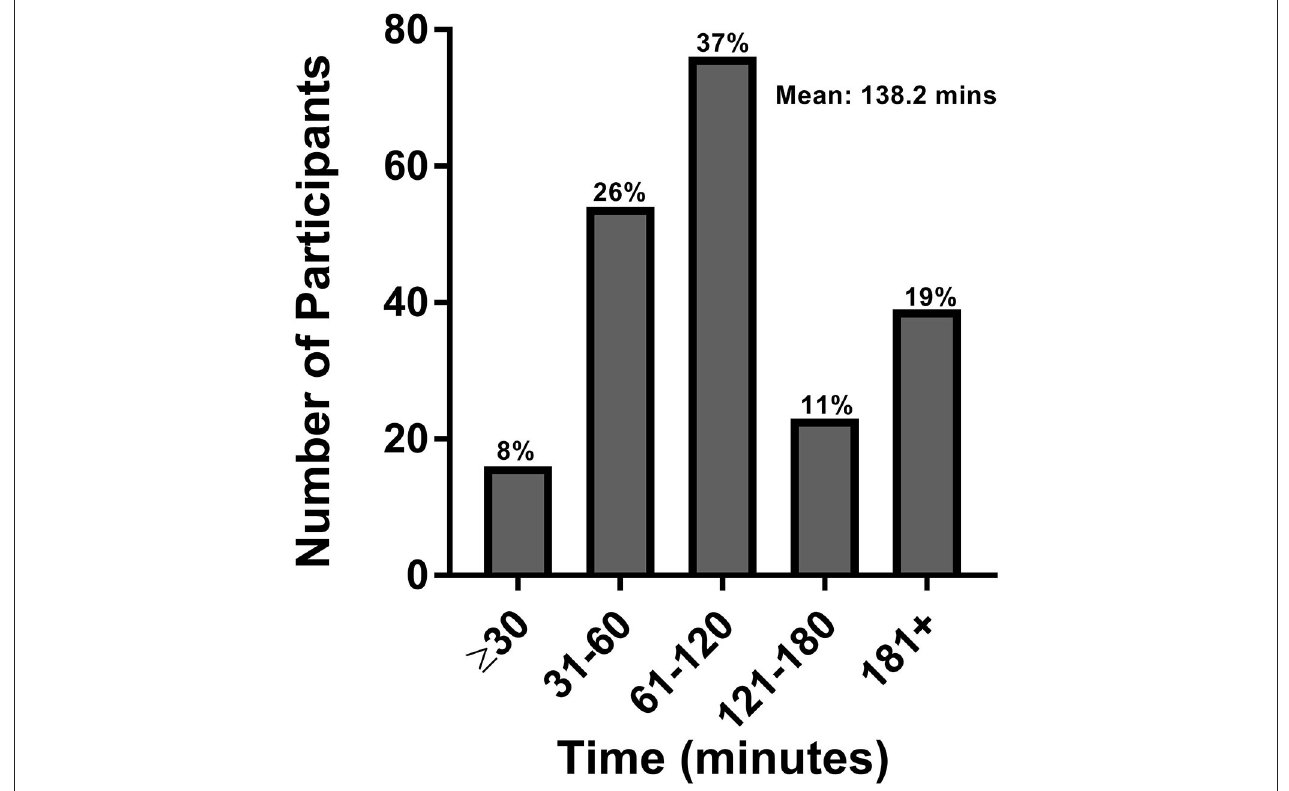
FIGURE 3 | Patient and caregiver commute time. This figure represents the total roundtrip commute time in minutes for patients and caregivers.